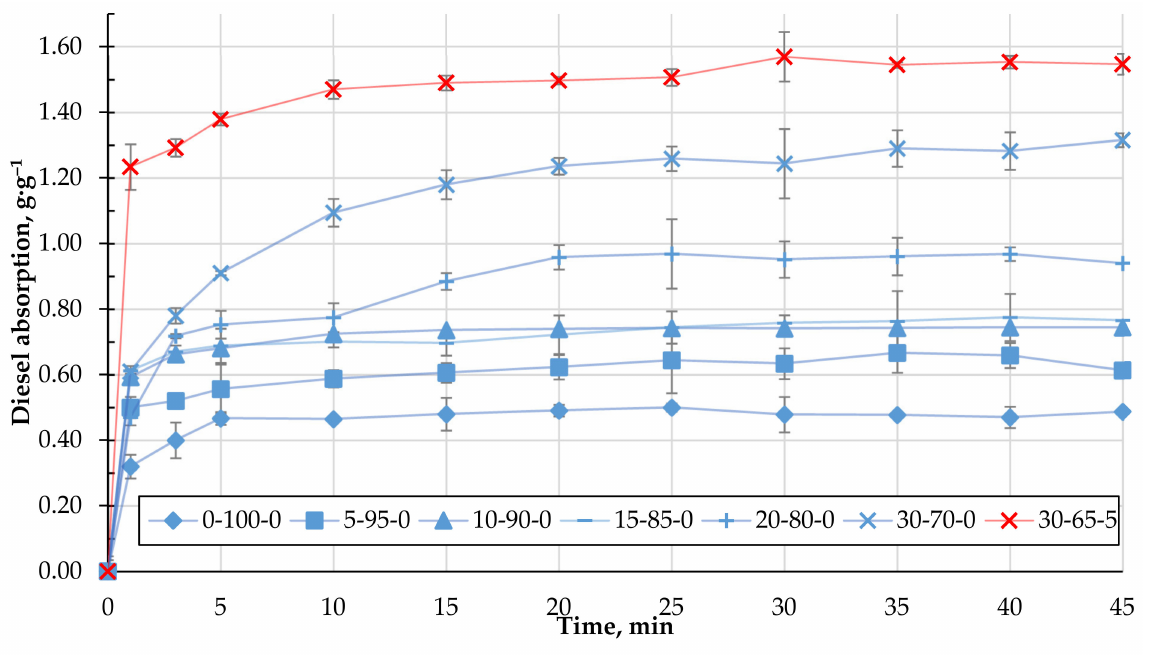
Figure 8. Adsorption kinetics of DF with biocomposite pellets containing